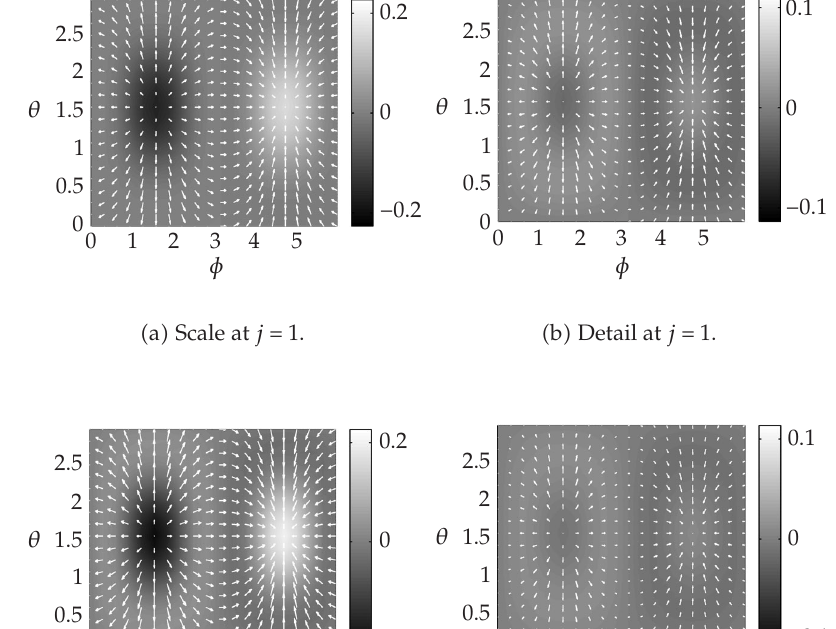
( d ) Detail at j = 2.